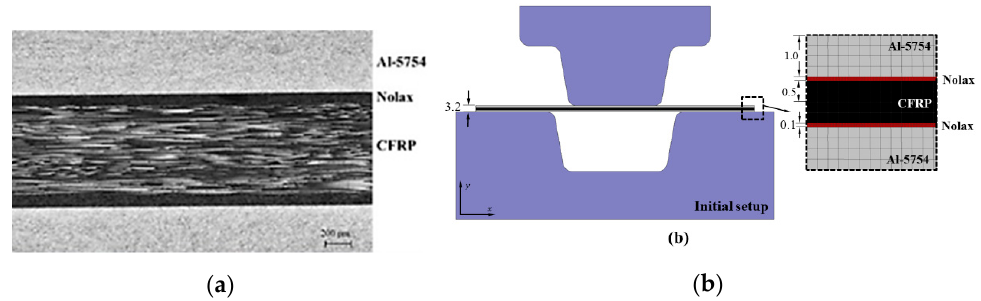
Figure 4. ( a ) Micrograph of lay-up L2 and ( b ) finite-element model and meshing system (dimensions in mm).